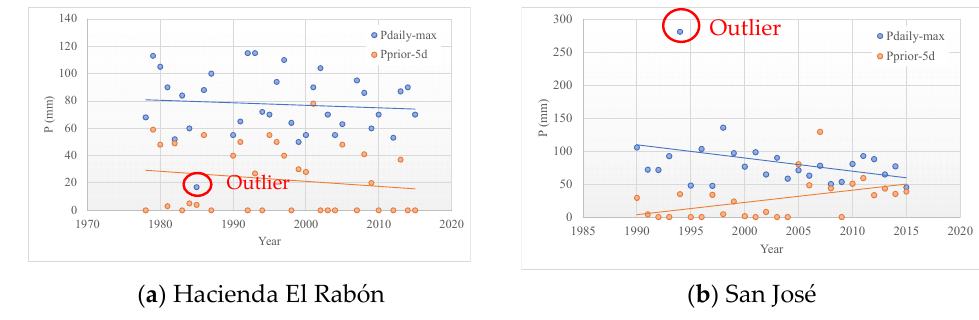
Figure 2. Outlier values of 24 h maximum rainfall records.